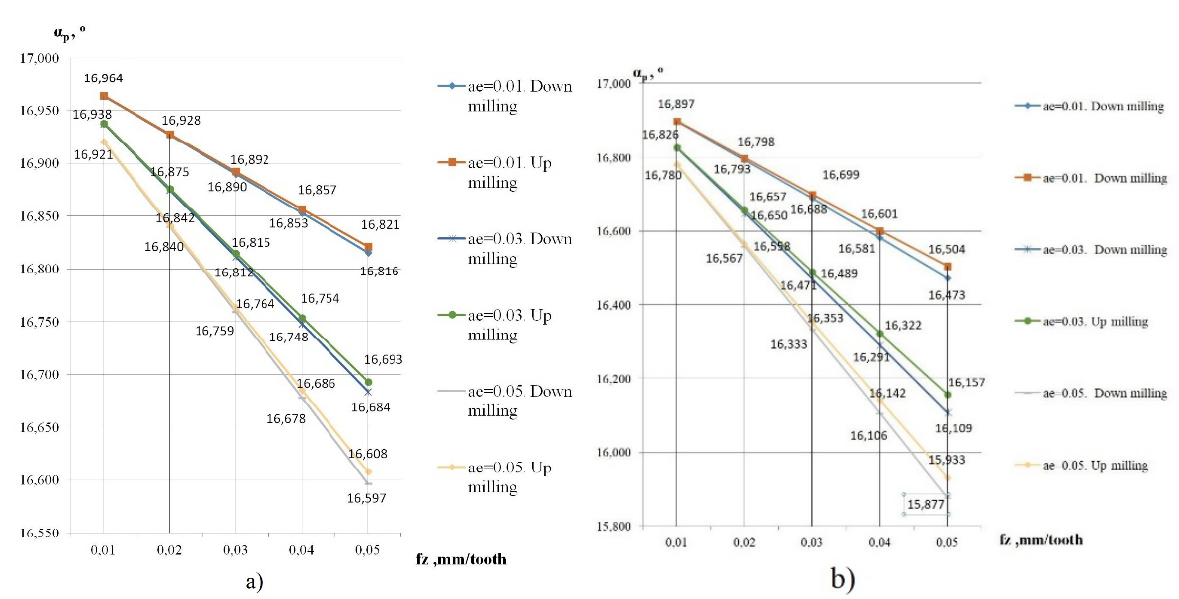
Fig. 6 . Dependencies of the kinematic clearance angle on feed per tooth f z with radial depth of cut a e =0.01, 0.03 and 0.05 mm for micro end mills: a) d =1 mm, b) d